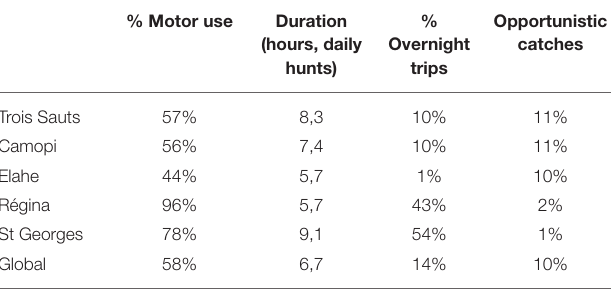
TABLE 5 | Hunting strategies in five study sites of French Guiana. % Motor use Duration % Opportunistic (hours, daily Overnight hunts) trips